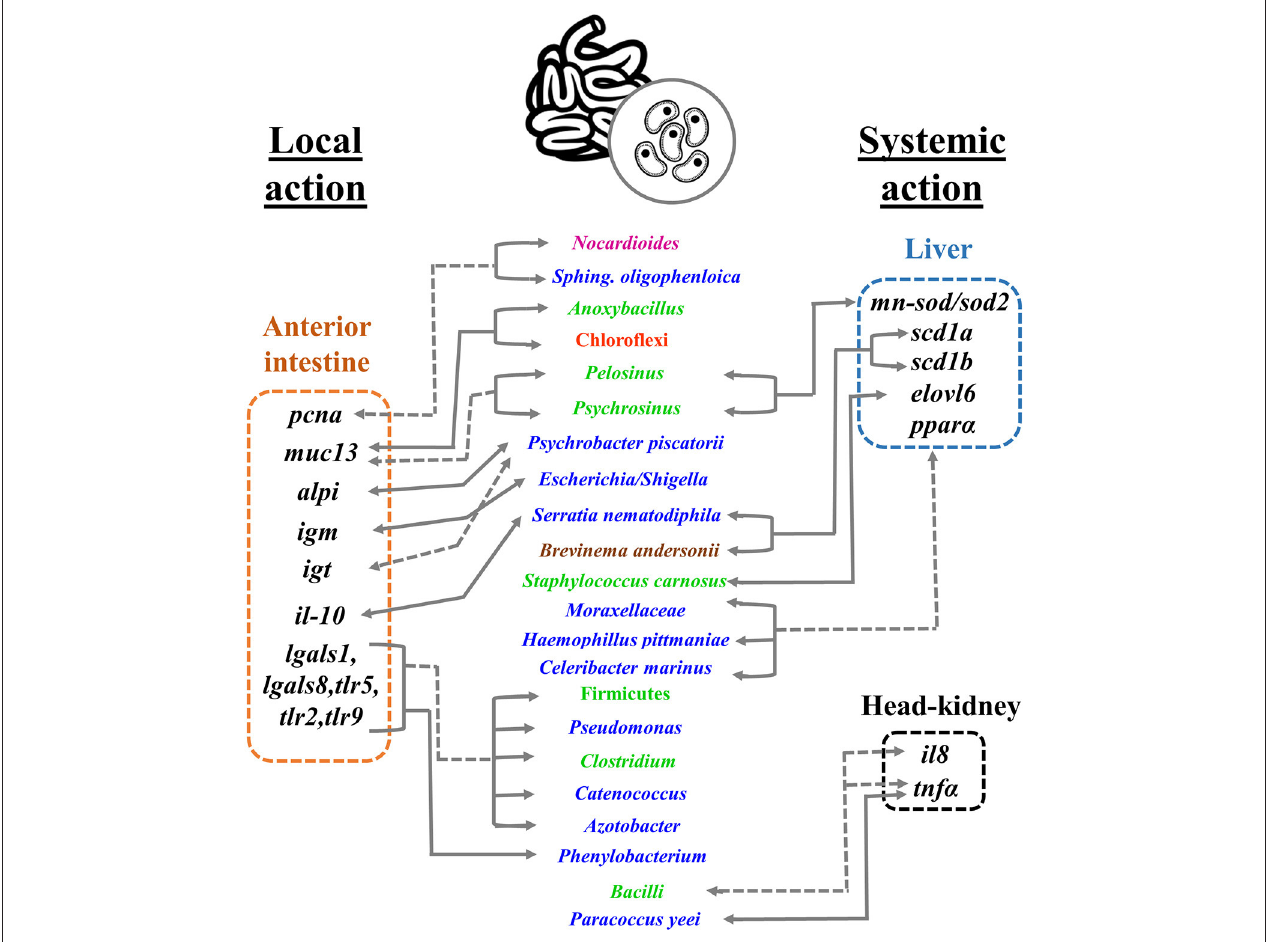
FIGURE 8 | Schematic representation of the main significant correlations between gut microbial community abundances and host gene expression at the local (AI) and systemic levels (liver, head-kidney). Gene symbols are boxed in dashed rectangles referring to each tissue: anterior intestine (orange), liver (blue), and head-kidney (black). Taxa names are in the middle column, with colors representing the phyla they belong: Proteobacteria (blue), Firmicutes (green), Actinobacteria (pink), Chloroflexi (red), and Spirochaetes (brown). Gray lines between taxa and gene symbol represent a positive (straight) or negative (dashed) correlation between gene and